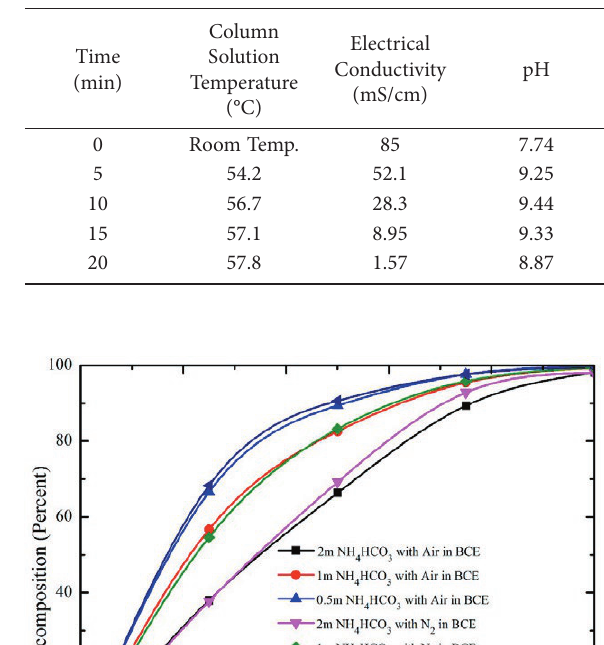
Table 1. Decomposition efficiency for an initial solution of 2 m